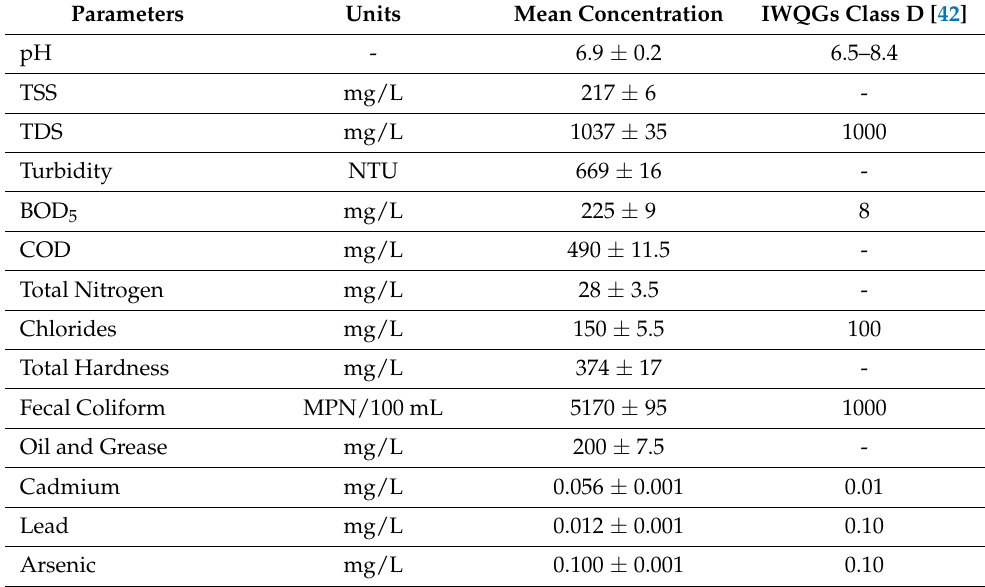
Table 2. Characteristics of real ASSWW and IWQGs.